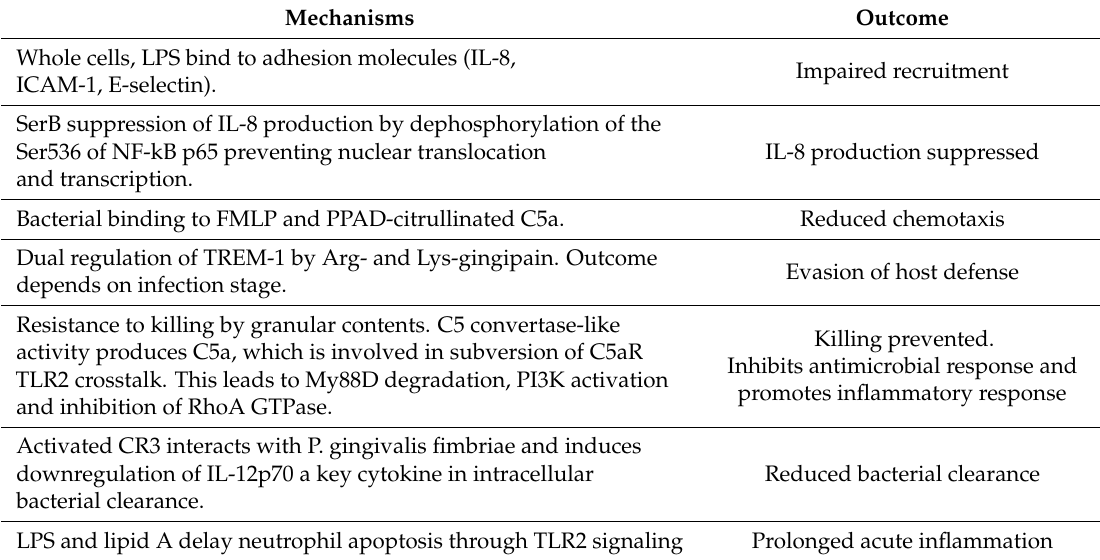
Table 1. Table showing various mechanisms of immune subversion and their outcome [84]. Mechanisms